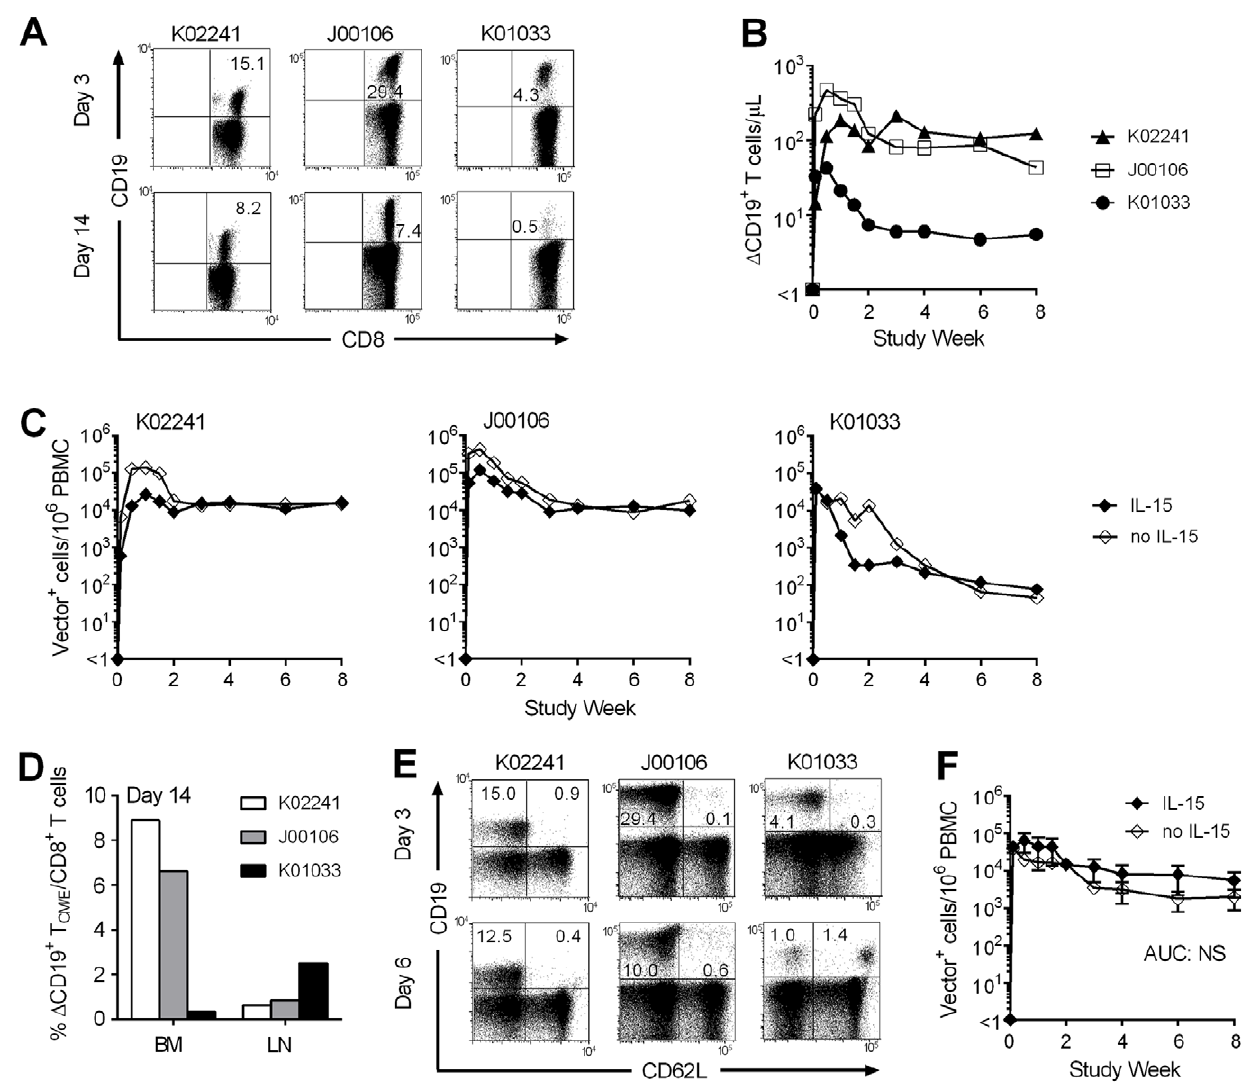
Figure 2. Persistence and migration of CMV-specific CD8 + T CM/E clones transferred with or without IL-15. (A,B) Flow cytometric analysis. PBMC were obtained before and after infusion of a D CD19 + CD8 + T CM/E clone (5 6 10 8 /kg) with IL-15. The frequency of transferred D CD19 + CD8 + T cells (%) within the CD3 + CD8 + subset was determined by flow cytometry after staining with mAbs specific for CD3, CD8, and CD19. (A) Shown are representative data of PBMC obtained on day 3 and 14. (B) Absolute numbers of persisting D CD19 + T CM/E cells in the peripheral blood. (C) Real-time qPCR. DNA was isolated from PBMC collected from each macaque before and after the D CD19 + T CM/E infusion with IL-15. Samples were examined by real-time qPCR for the presence of D CD19 + T cells (Vector + cells) given with IL-15 (closed diamond). A second infusion of the identical CD20-marked T CM/E clone was given to each of the animals without IL-15 (open diamond). The frequency of CD20 + (Vector + ) T cells in PBMC was assessed by qPCR. Persistence data are presented as overlay. (D) Migration. BM and LNs samples were obtained from each macaque on day 14 after the D CD19 + CD8 + T CM/E infusion with IL-15, stained with mAbs specific for CD3, CD8, and CD19, and examined by flow cytometry after gating on CD3 + CD8 + cells. (E) CD62L expression. PBMC obtained on day 3 and 6 after the D CD19 + CD8 + T CME transfer with IL-15, were stained with mAbs to detect CD3, CD8, CD19, and CD62L, and examined by flow cytometry after gating on CD3 + CD8 + cells. (F) Persistence of polyclonal CD8 + T CM/E cells without or with IL-15 in the peripheral blood. Each of 4 macaques received sequential infusions of either CD20 + or D CD19 + polyclonal CD8 + T CM/E cells (5 6 10 8 /kg) without (open diamond) or with IL-15 (closed diamond). Pre- and post-infusion DNA samples were analyzed by real-time qPCR for the presence of vector + T cells. Shown are mean 6 SEM. NS, not